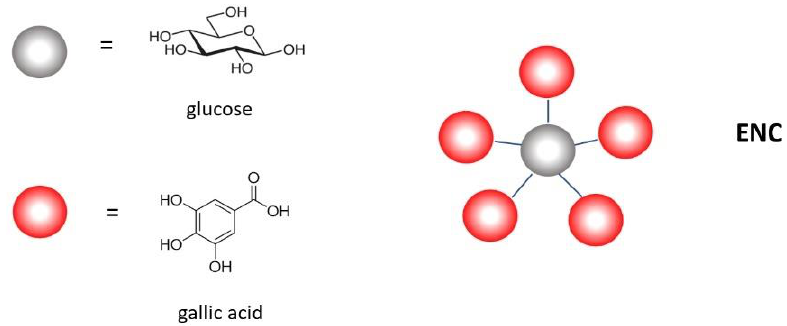
Figure 1. Most represented structures in ENC.